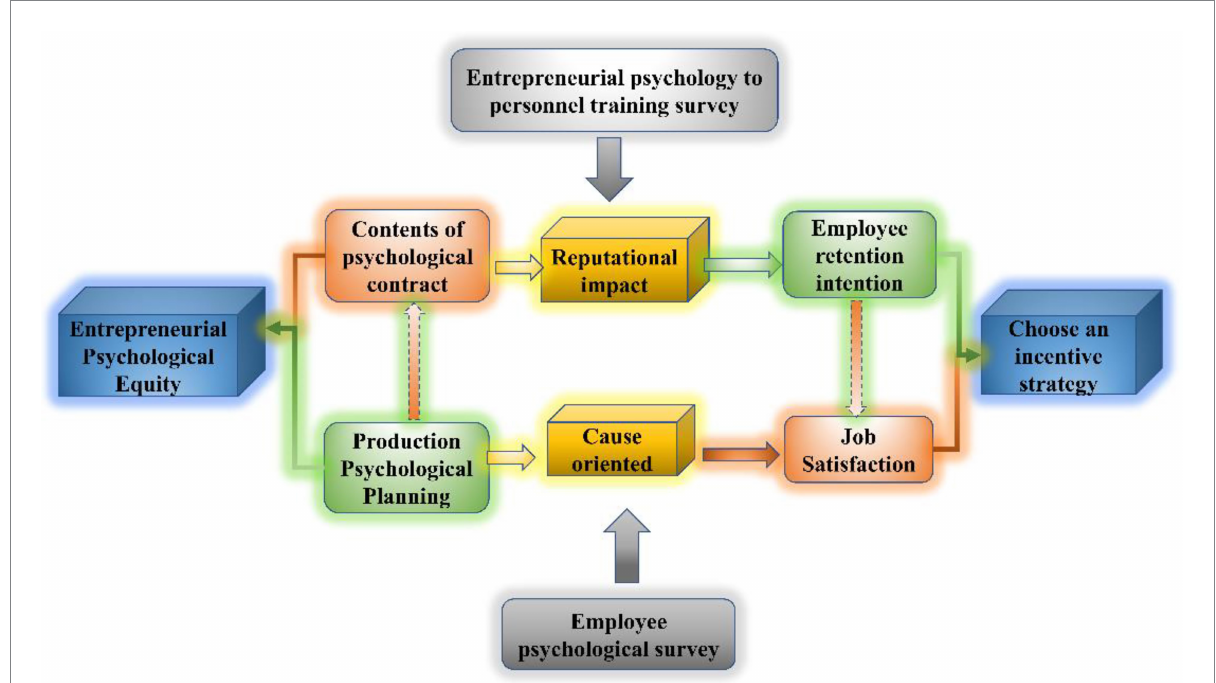
FIGURE 1 The extraction process of manufacturing transformation mental organization